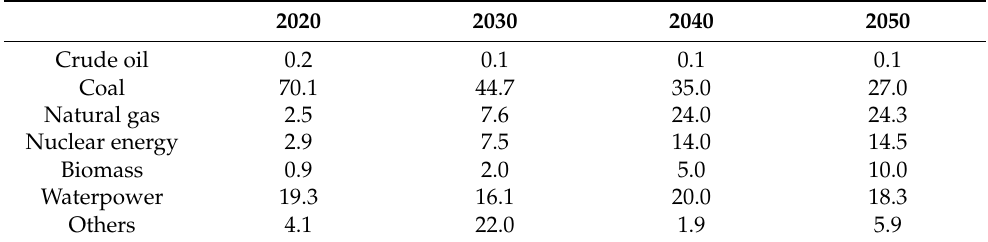
Table 2. The proportion of China’s energy mix for power generation in different years/%.